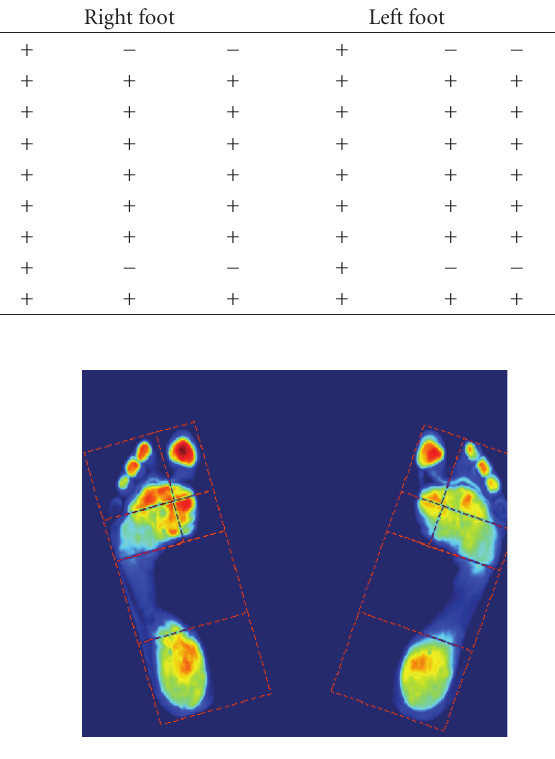
Figure 7: Pressure distribution patterns, including maximum